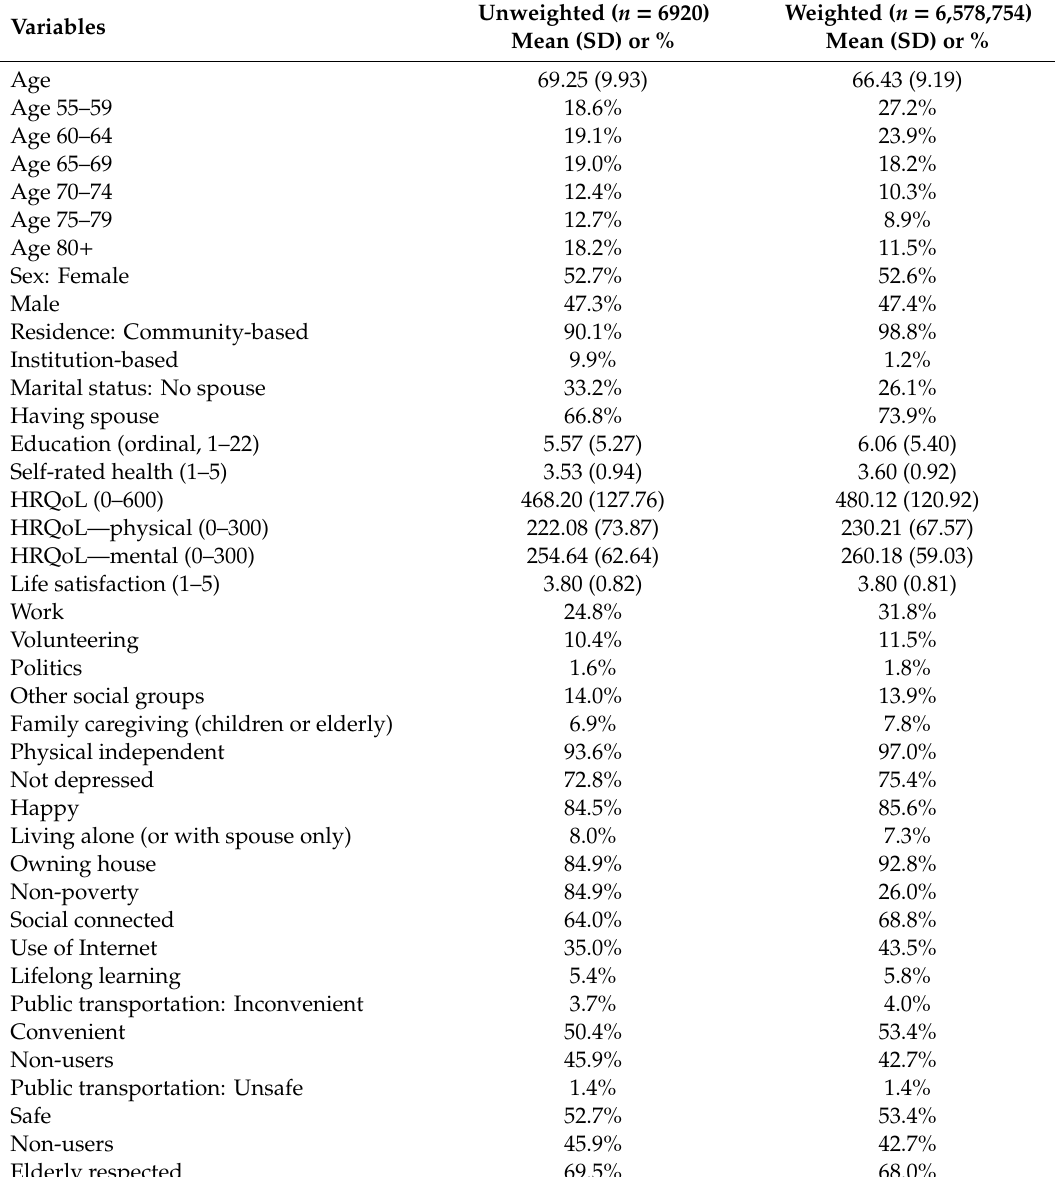
Table 1. Description of the